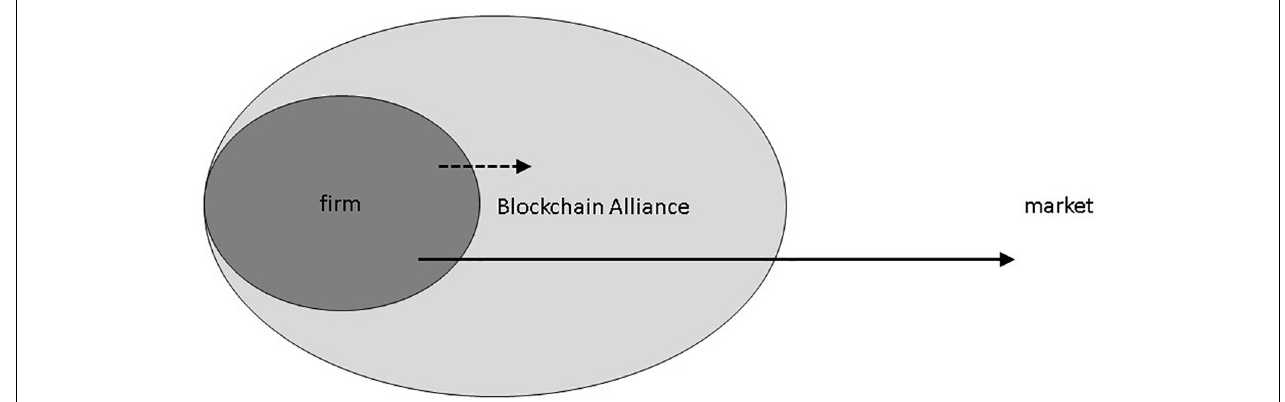
FIGURE 2 | Firm and alliance boundaries in approaching the